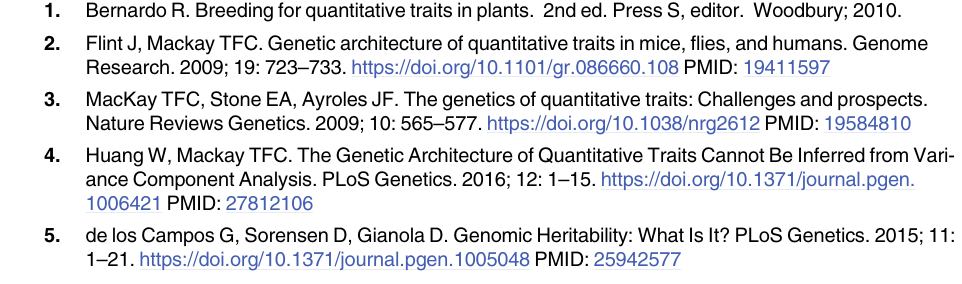
S5 Fig. Genomic window build from 1000 SNPs around the QTL simulated on the seventh chromosome. (JPEG) S6 Fig. Genomic window build from 3100 SNPs around the two QTL simulated on the eighth chromosome. (JPEG) S7 Fig. Genomic window build from 2000 SNPs around the QTL simulated on the ninth chromosome. (JPEG) S8 Fig. Genomic window build from 1000 SNPs around the first QTL simulated on the tenth chromosome. (JPEG) S9 Fig. Genomic window build from 1500 SNPs around the two last QTL simulated on the tenth chromosome. (JPEG) S10 Fig. Absolute simulated actual effects of QTL along the human’s genome and absolute estimates from methods rr-BLUP (RR), Bayes B (BB) and Bayesian Lasso (BL). (JPG) S11 Fig. Absolute simulated actual effects of QTL along the human’s genome and absolute estimates from the methods for Bin 0.001, Bin 0.005 and Bin 0.01.